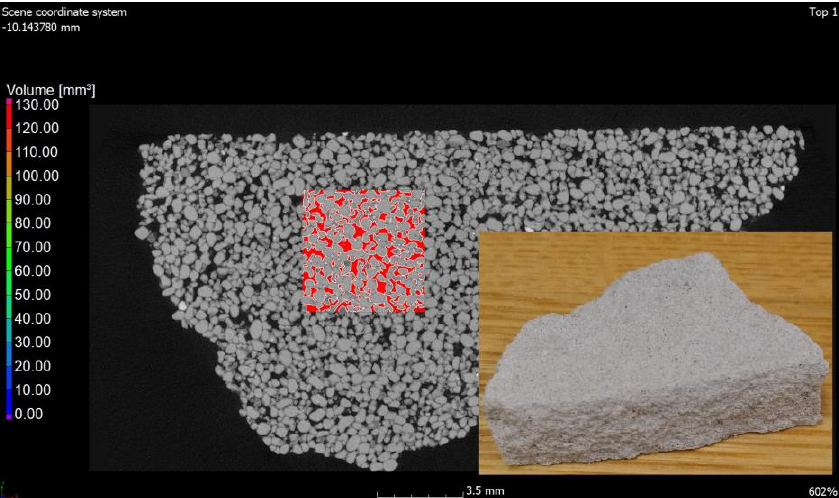
Figure 6. Photo of traditional material (reference sample) examined with computed tomography.